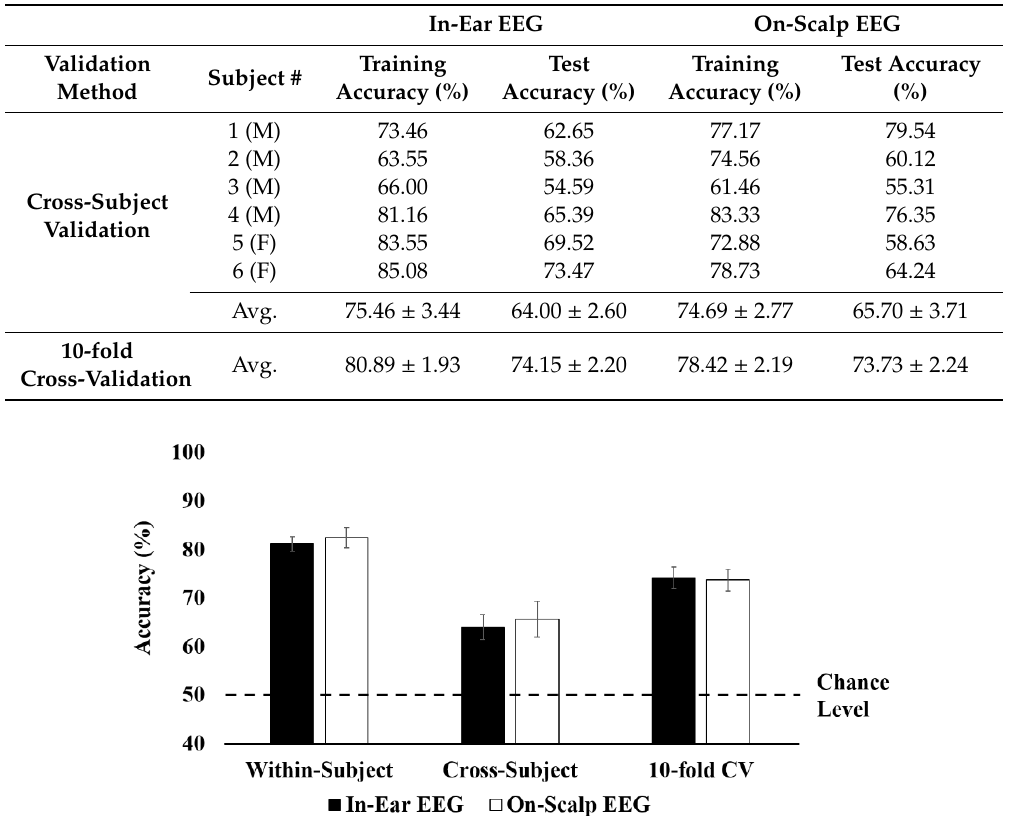
Figure 5. The test accuracy for three cross-validation schemes: within-subject validation, cross-subject validation, and 10-fold cross-validation (CV).